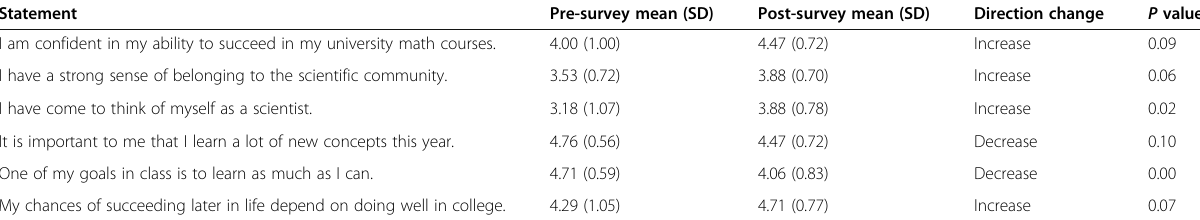
Table 1 Mean agreement with the survey statement for the control group